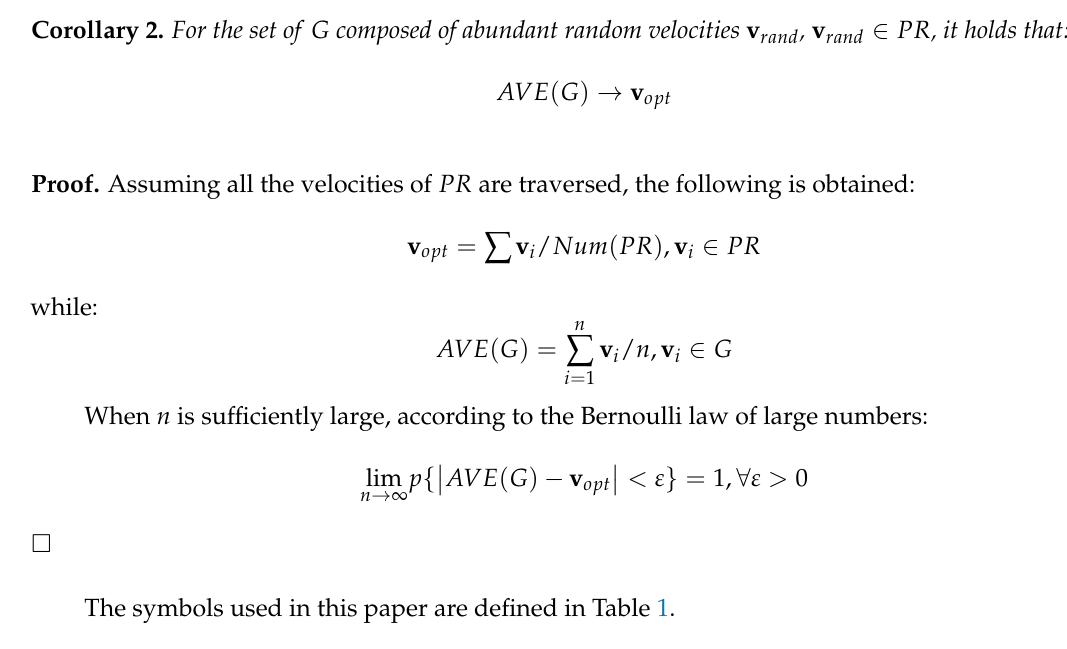
Table 1. Symbols and their